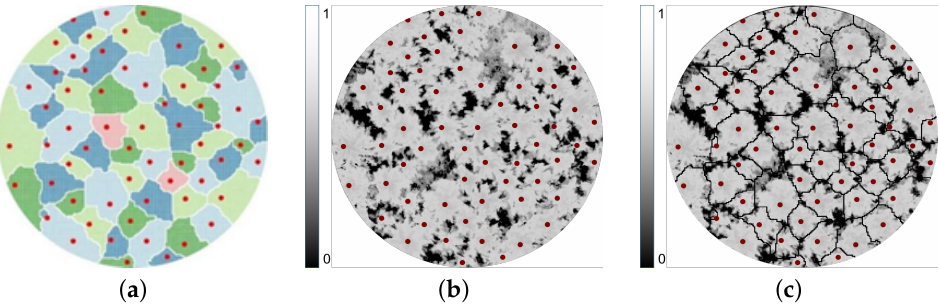
Figure 6. ( a ) Marker-controlled watershed segmentation using the treetops (red dots) as markers, used to detect the watershed regions (coloured areas) and ridges (white lines) in the canopy height model (CHM); ( b ) fractional map of the crown class u c ∈ [0, 1] with all u c pixels with u c < u b set to 0;